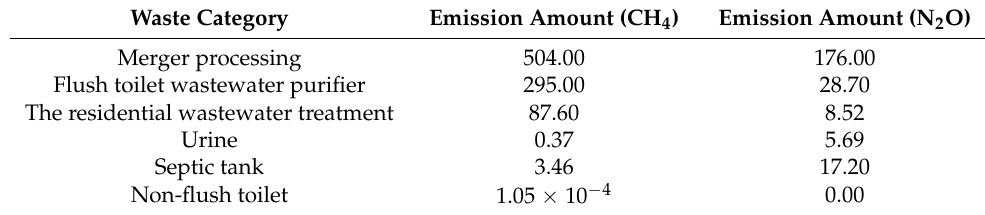
Table 9. GHG emissions overview of residential